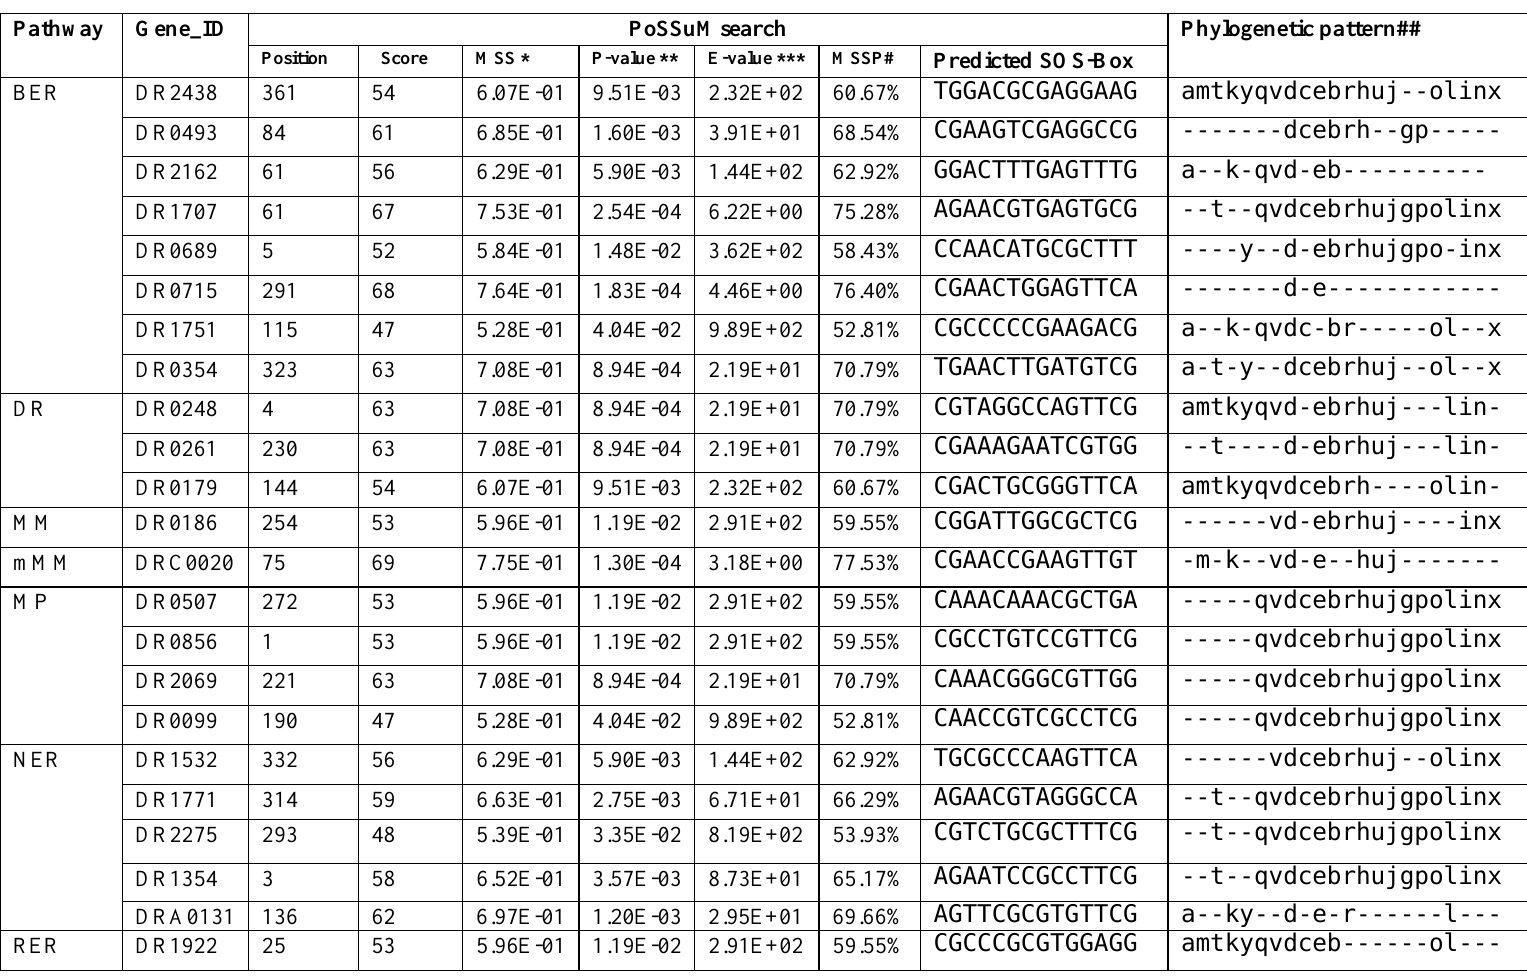
Supplementary Table 6 (S6): Details of similar SOS-box motifs predicted in the upstream sequences of D. radiodurans genes related to replication, repair and recombination functions through PoSSuMsearch